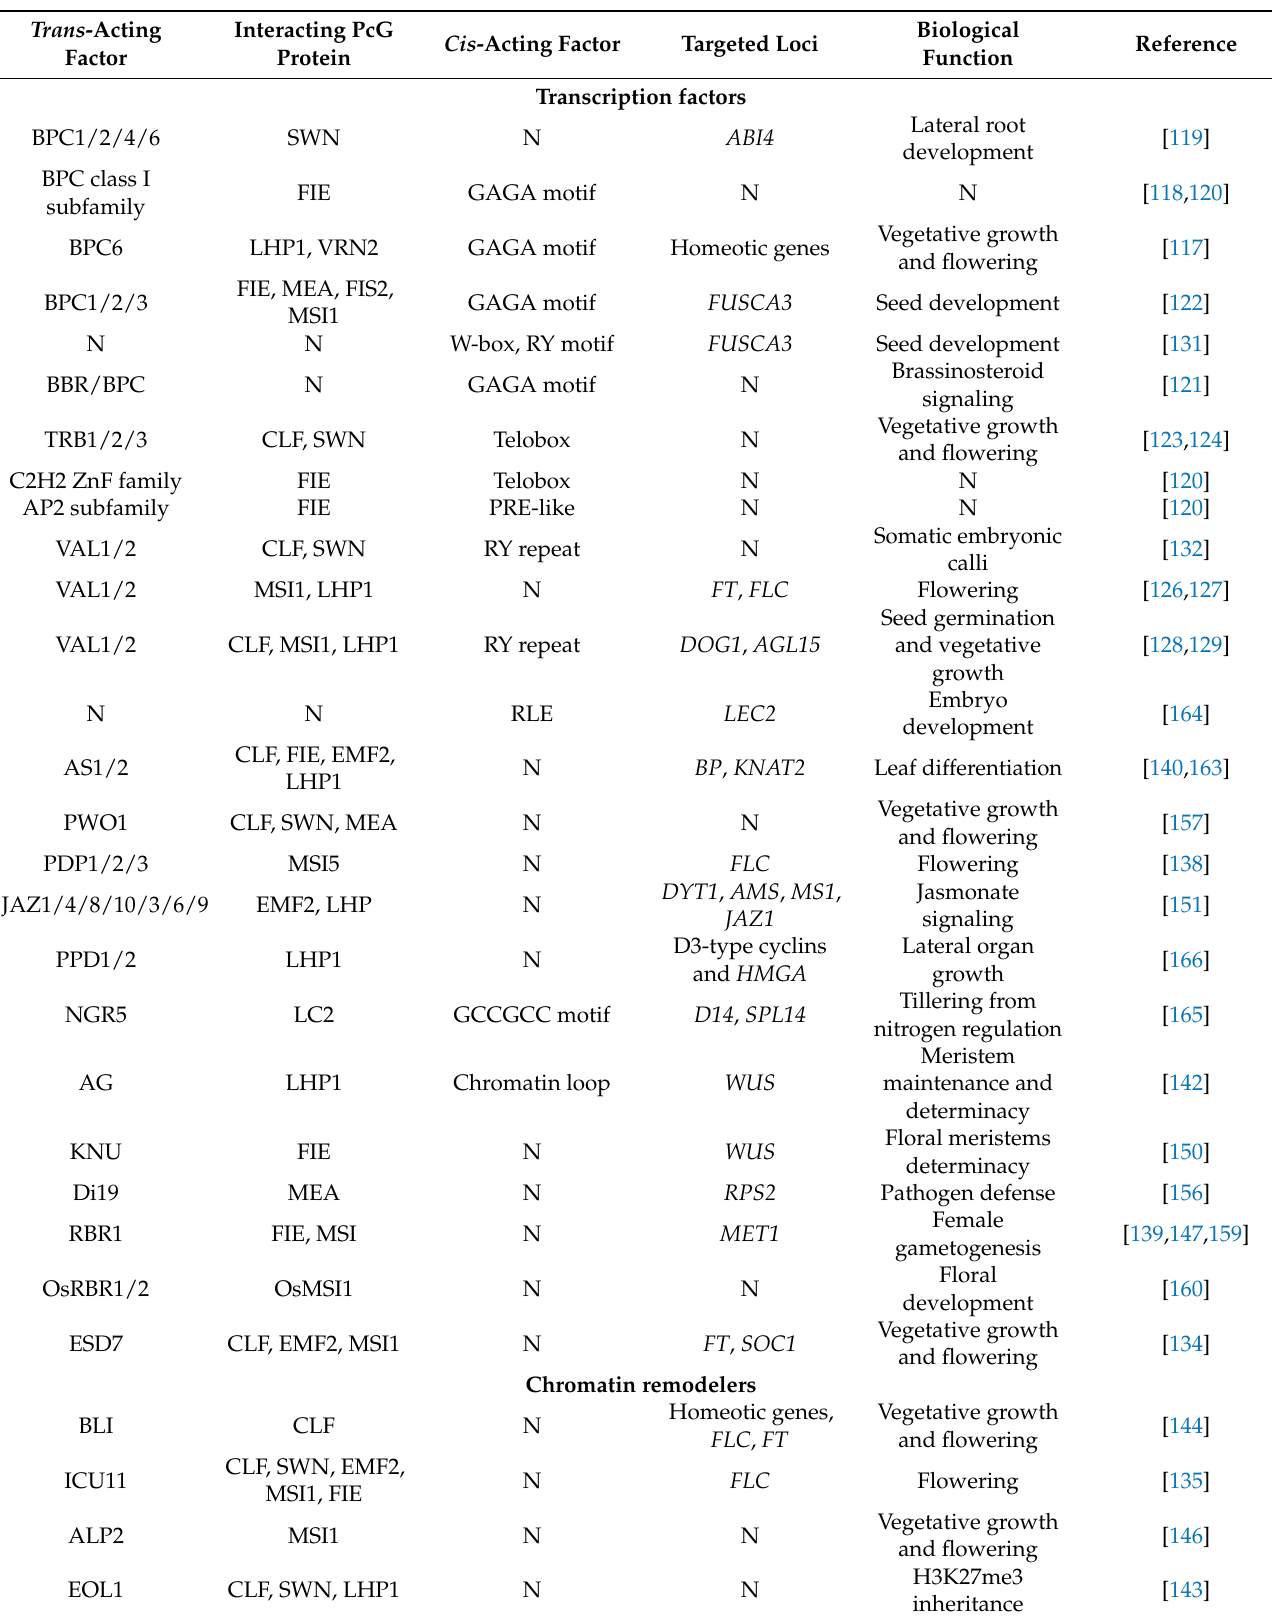
Table 2. Cis - and trans -acting factors involved in PRC2 recruitment in